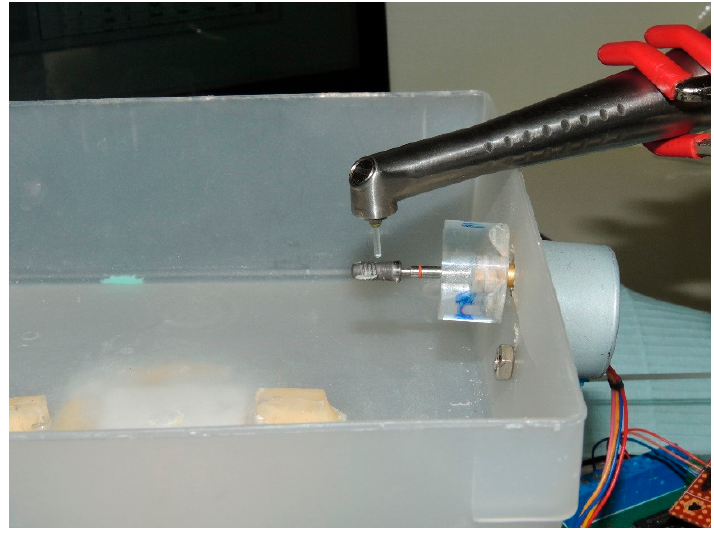
Figure 1. The custom-designed device.